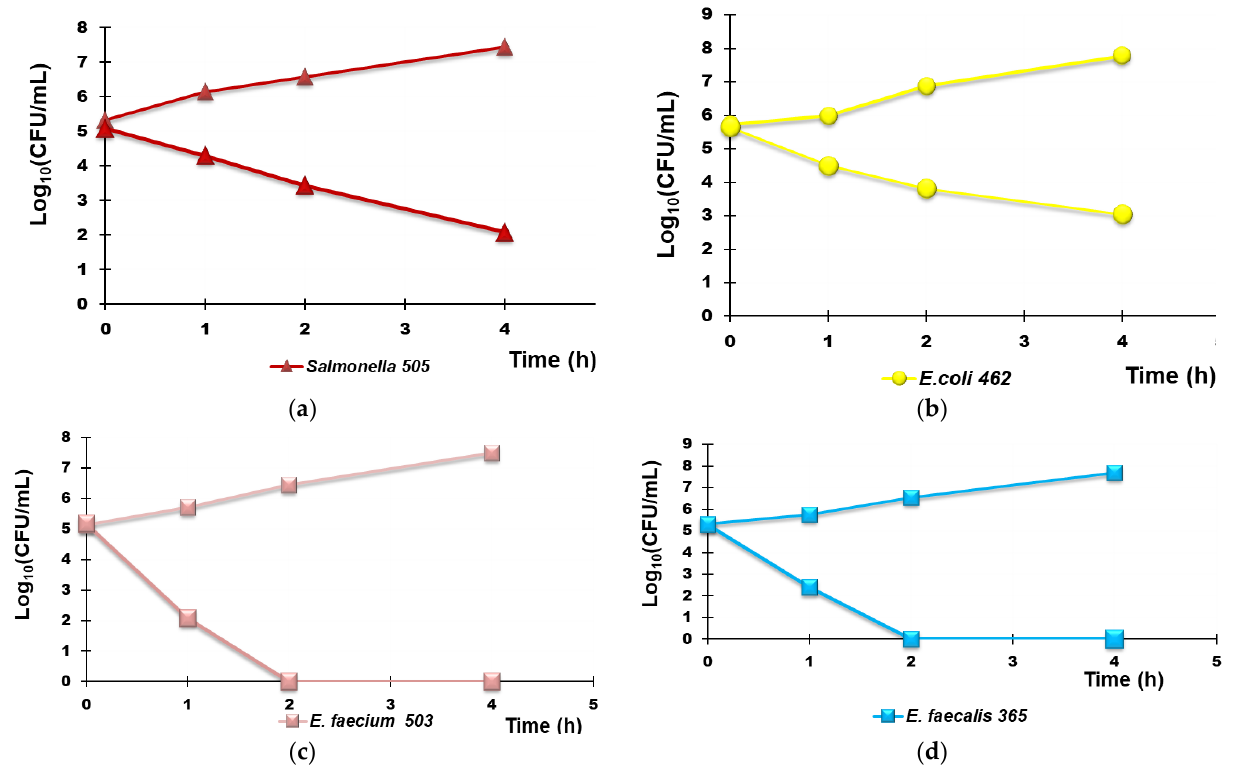
Figure 10. Representative results of the TK experiments obtained from treating each R4 species separately for 4 h. Group B Salmonella species strain 505 ( a ), E. coli 462 (a strain New Delhi metallo- β - lactamase producer ( b ), E. faecium 503 ( c ), and E. faecalis 365 ( d ).